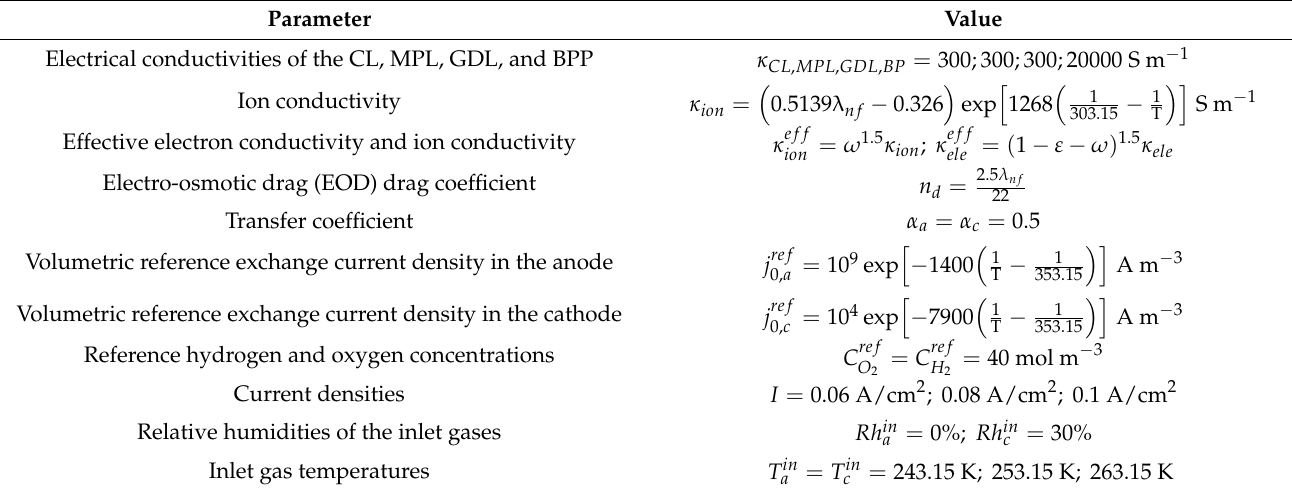
Table 6. Electrochemical parameters